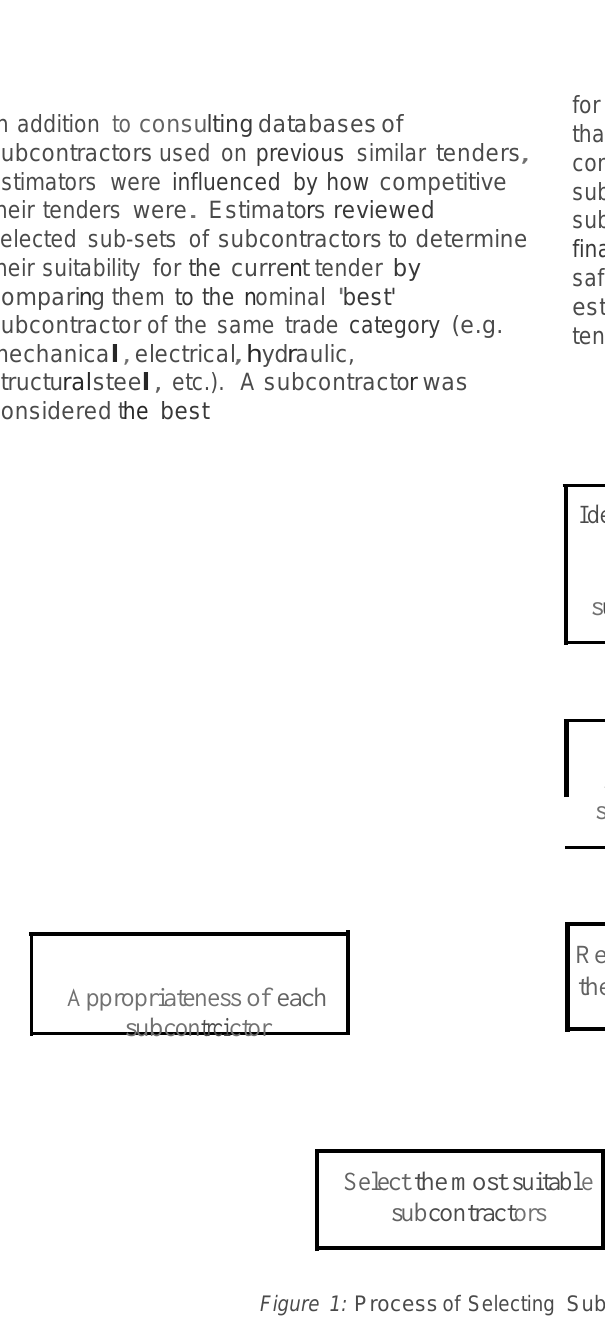
FRAMEWORK FOR THE CBR